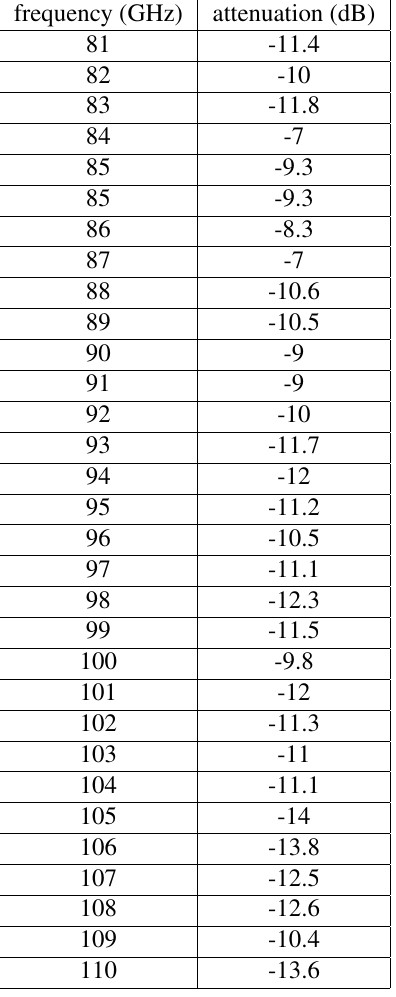
Table 1. The attenuation of the 40 meters transmission waveguide for di ff erent